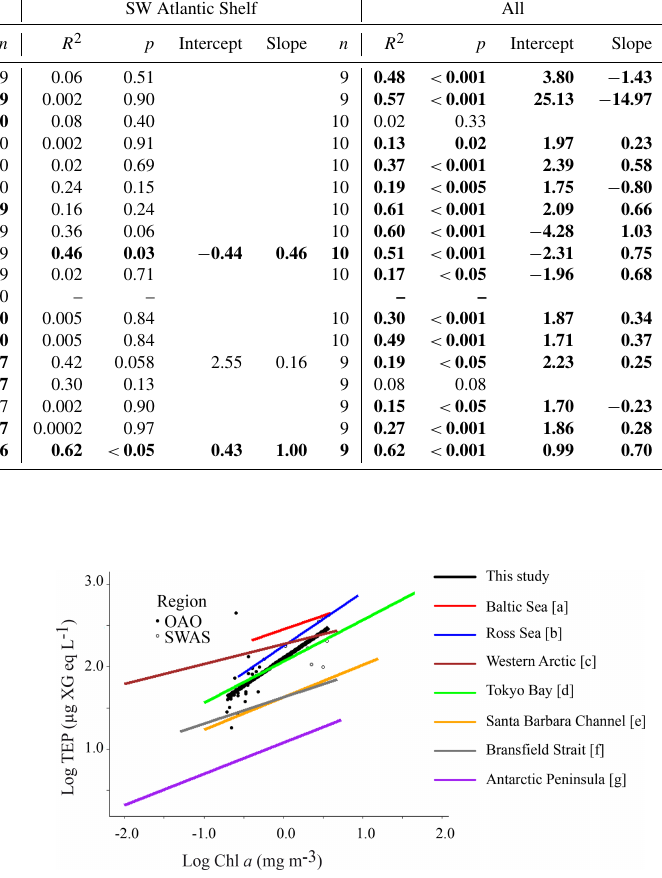
Figure 5. Relationship between TEP and Chl a concentration from the TransPEGASO cruise, with the linear regression line (regres- sion equation in the text). Two regions are distinguished: open At- lantic Ocean (OAO, CU included, filled circles) and SW Atlantic Shelf (SWAS, empty circles). Regression lines from the literature are also shown for comparison. α and β indicate the y intercept and slope, respectively; log TEP (µgXGeqL − 1 ) = α + β × logChl a (mgm − 3 ); (a) α = 2 . 45 and β = 0 . 33, (Engel, 1998 in Passow, 2002a); (b) α = 2 . 25 and β = 0 . 65, (Hong et al., 1997); (c) α = 2 . 27 and β = 0 . 24, (Yamada et al., 2015); (d) α = 2 . 06 and β = 0 . 50, (Ramaiah and Furuya, 2002); (e) α = 1 . 63 and β = 0 . 39, (Pas- sow and Alldredge, 1995); (f) α = 1 . 63 and β = 0 . 32, (Corzo et al., 2005); (g) α = 1 . 08 and β = 0 . 38, (Ortega-Retuerta et al.,